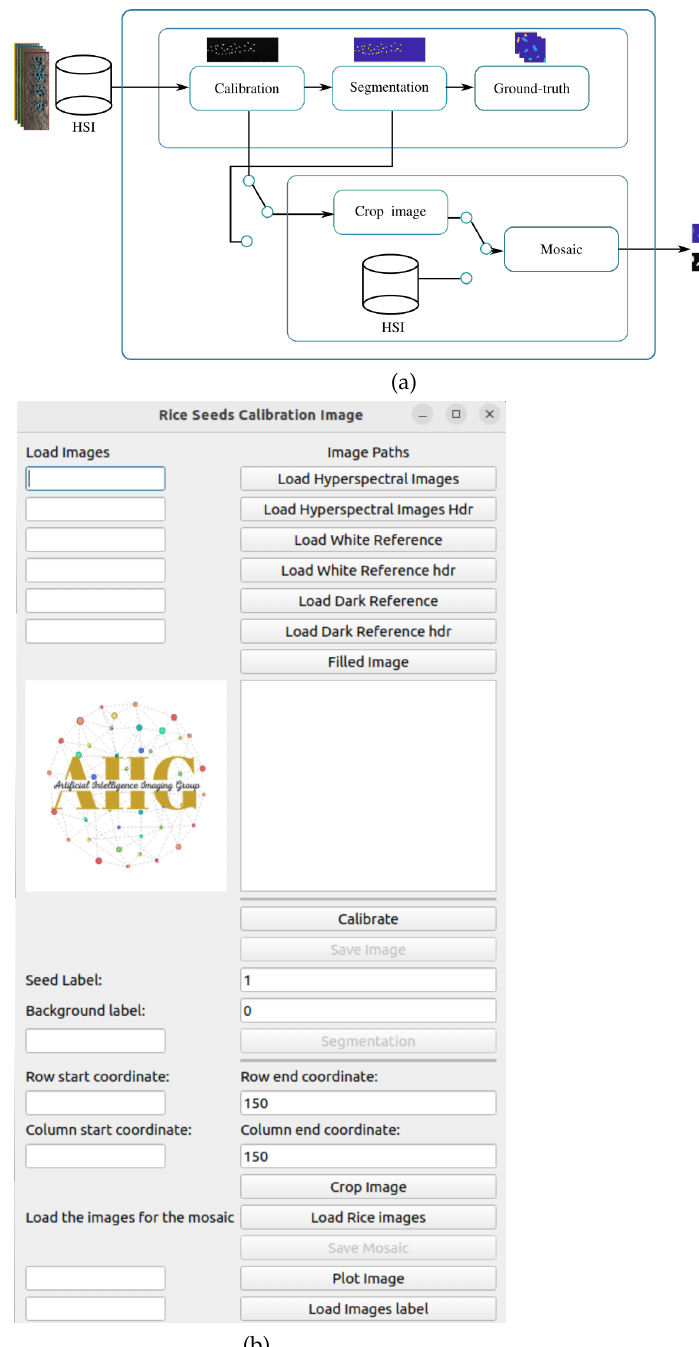
Figure 3. ( a ) Workflow for HSI seed images and ground truth mosaic construction, ( b ) HSI seed calibration